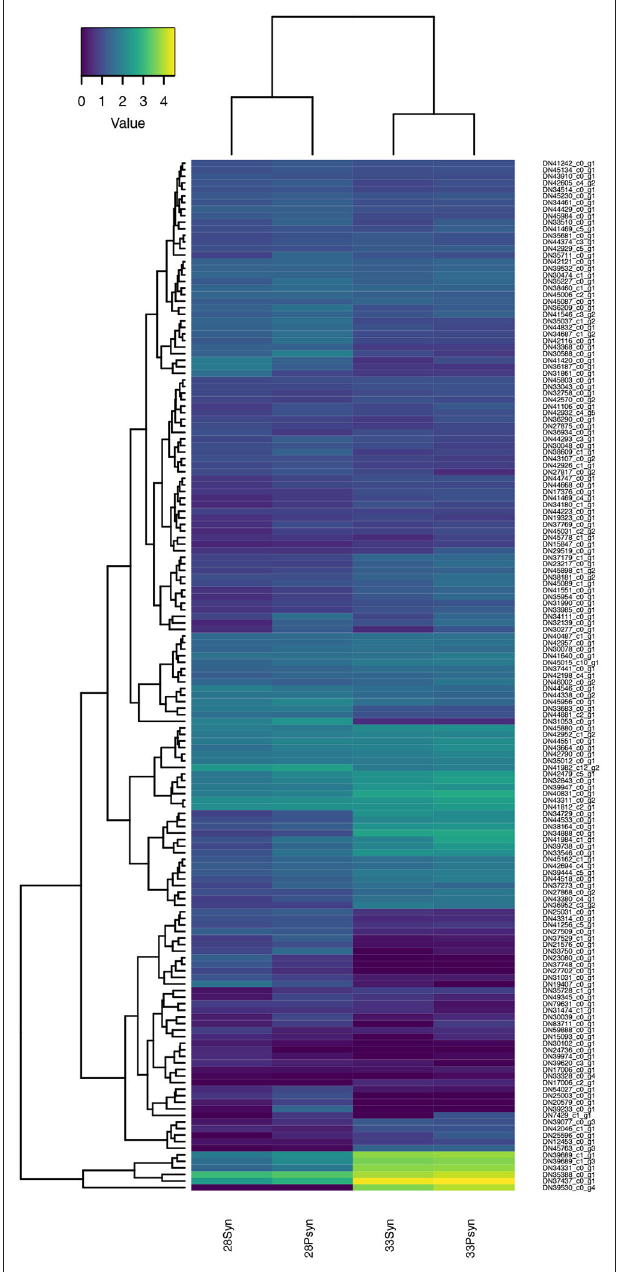
FIGURE 10 | Heatmap of normalized expression for genes annotated to the gene ontology term “cartilage development” (GO:0051216). A cluster of these genes, including Col2A1-like , Col10A1-like, and Col11A1-like genes, have increased expression at stage 33.